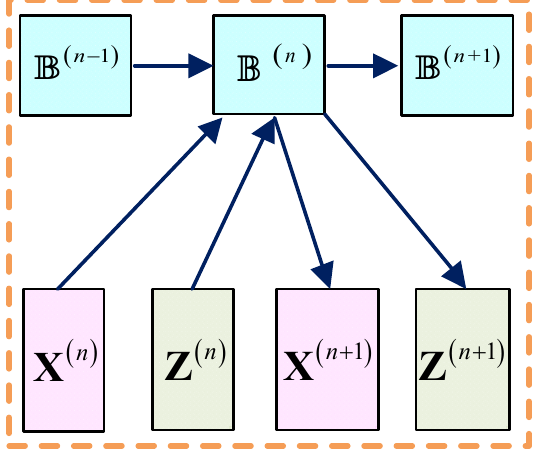
Figure 4. Multiplier update layer.